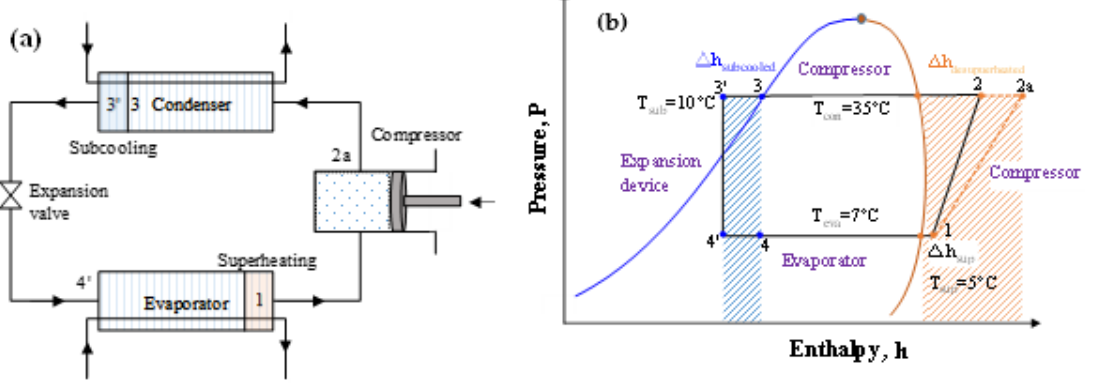
Figure 8. ( a ) Schematic of the vapor compression cycle with subcooled heat and superheat. ( b ) Conceptual P–h diagram where the subcooled and desuperheated areas are textured.